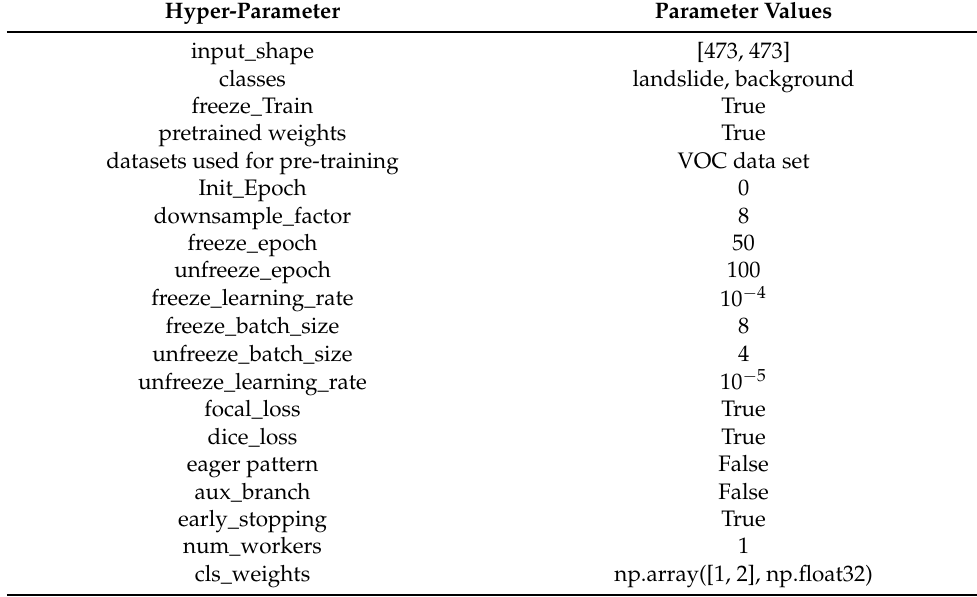
Table 4. Parameters for our models. Hyper-Parameter Parameter Values